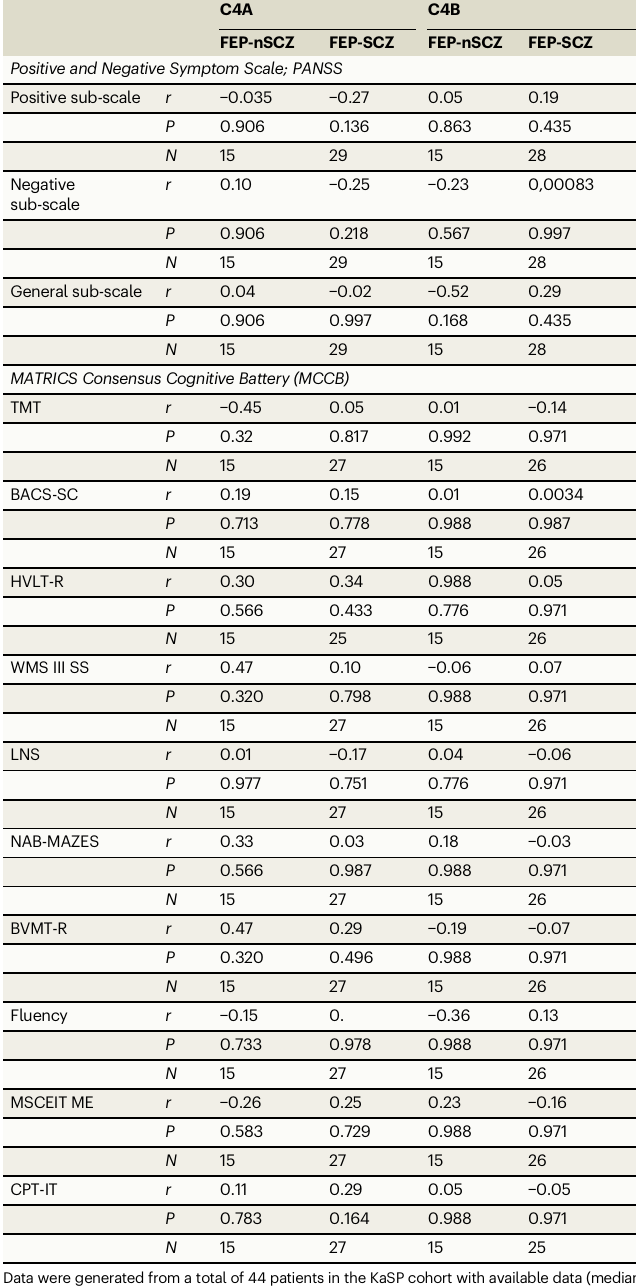
Table 1 | Correlations of CSF C4A and C4B concentration to the Positive and Negative Syndrome Scale (PANSS) scores, and performance in the key domains of the MATRICS Con- sensus Cognitive Battery